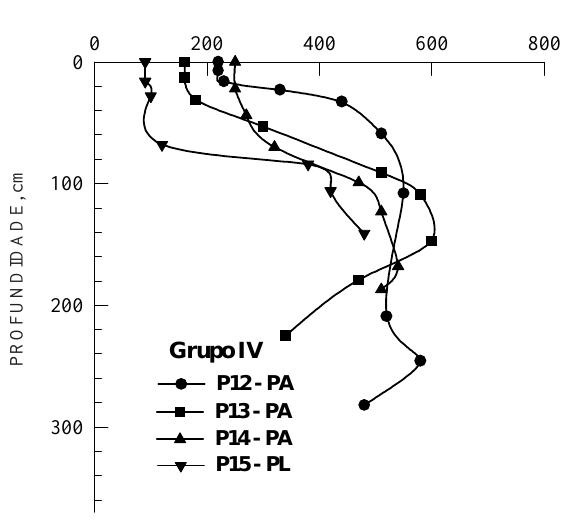
Figura 8. Curvas de distribuição da argila total em profundidade nos perfis desenvolvidos de sedimentos coluviais.